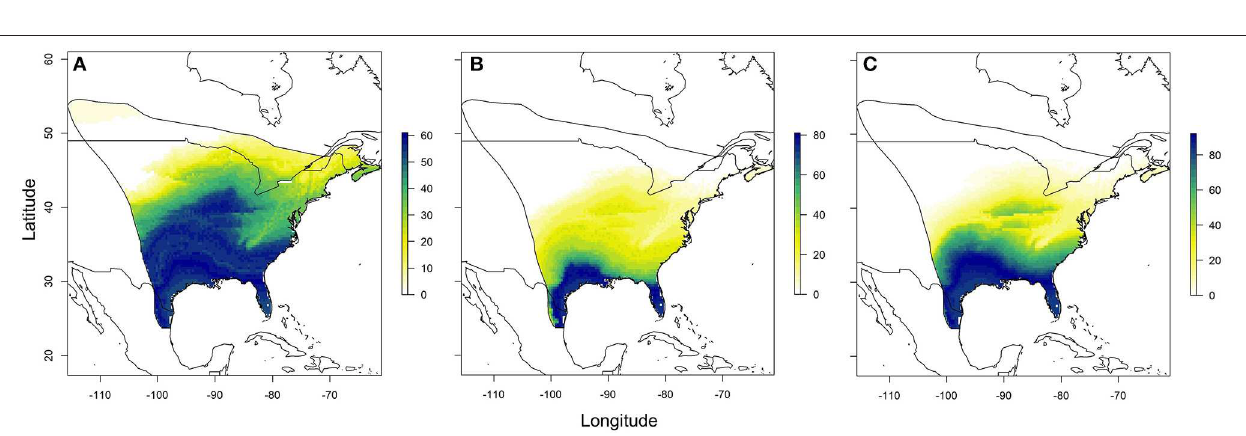
FIGURE 4 | Depiction of (A) the expected monarch δ 18 O w isoscape based on the relationship derived between δ 18 O w and amount-weighted mean growing season average δ 18 O p (Bowen et al., 2005) shown in Figure 2 and (B) the expected monarch δ 2 H w isoscape based on the relationship derived between δ 2 H w and amount-weighted mean growing-season average δ 2 H p (Bowen et al., 2005) shown in Figure 3 . Legend is the number of individuals assigned to a pixel based on the odds ratio criterion used.